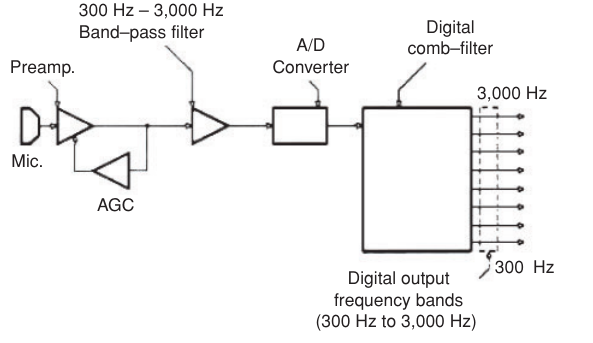
Figure 2 Sound pickup and spectrum analyser.